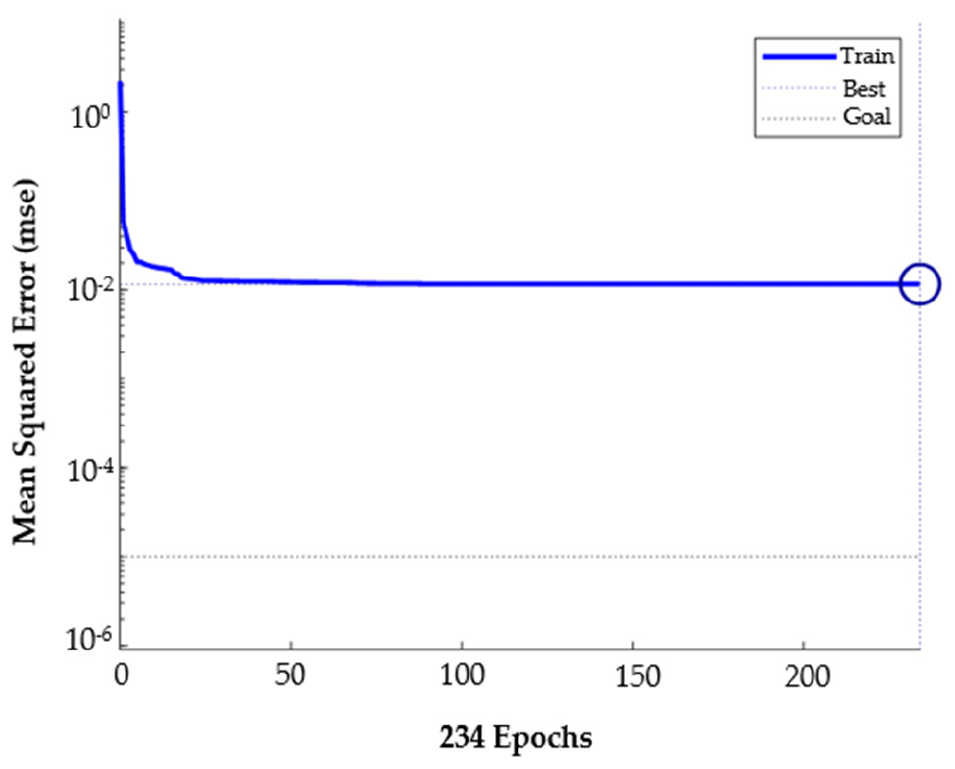
Figure 8. The trendline of training loss versus epochs.